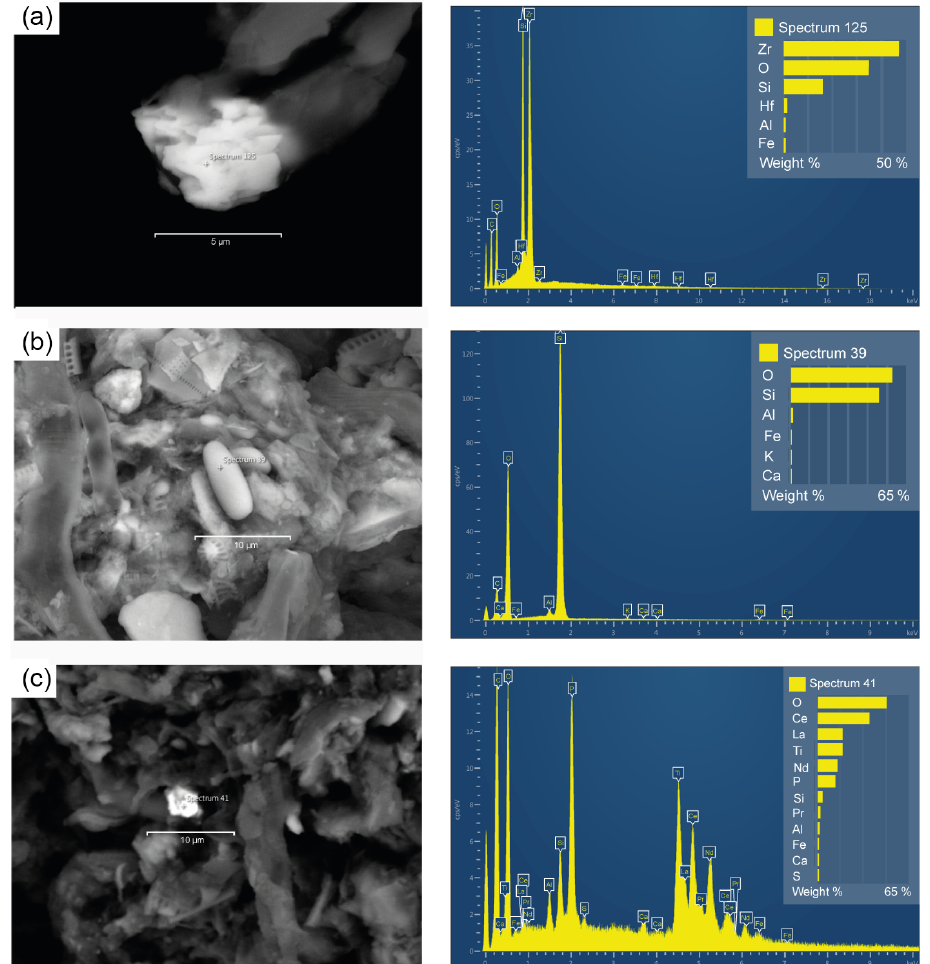
Figure 6. Electron backscatter diffraction microphotographs of the Laguna Hondera record with clearer colours representing heavier miner- als. The dendrograms represent the elemental composition of each mineral. (a) Zircon, with high Zr content; (b) rounded quartz related with eolian transport; (c) monazite, with high REE